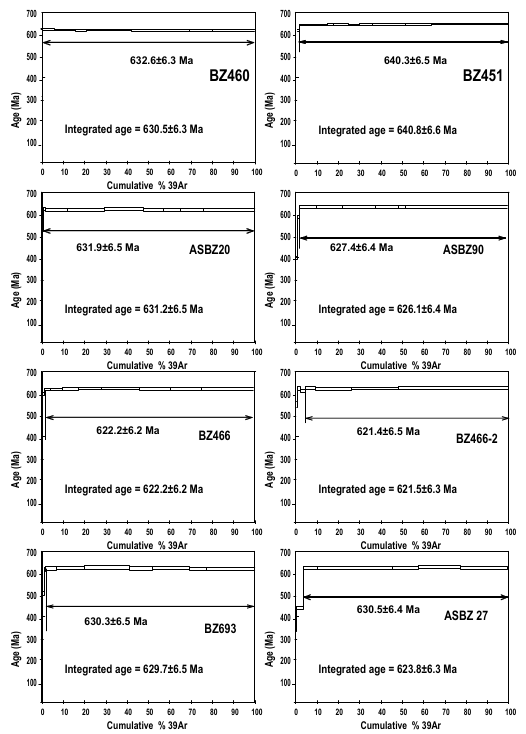
Figure 8. Results for the 40 Ar/ 39 Ar dating of lamprophyre dykes and stocks inside the BZM.